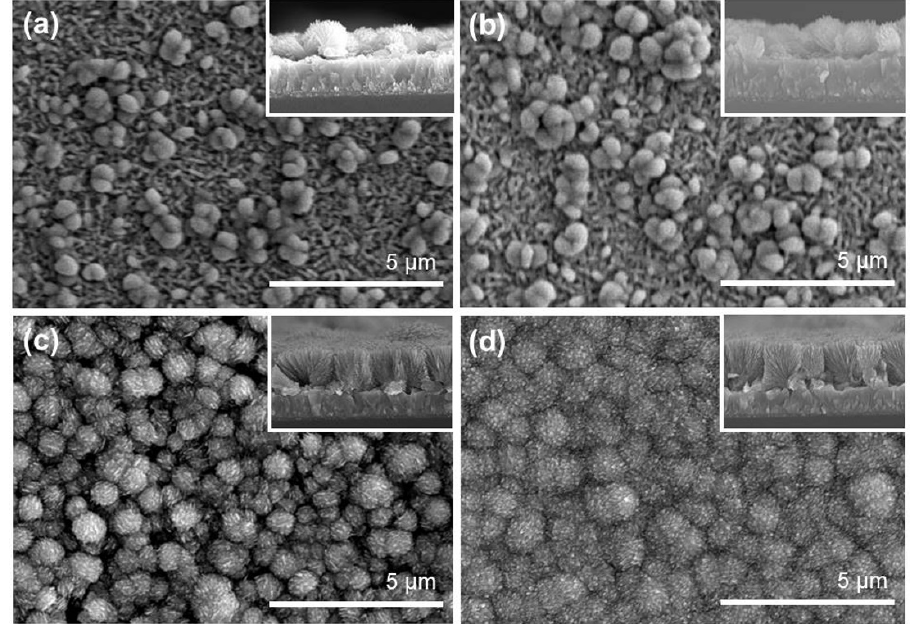
Figure 2. SEM images of CuO thin films synthesized under different temperatures (100 °C and 150 °C) and precursor concentration (0.1 M and 0.5 M). Note: ( a ) S01100; ( b ) S01150; ( c ) S05100; ( d ) S05150.